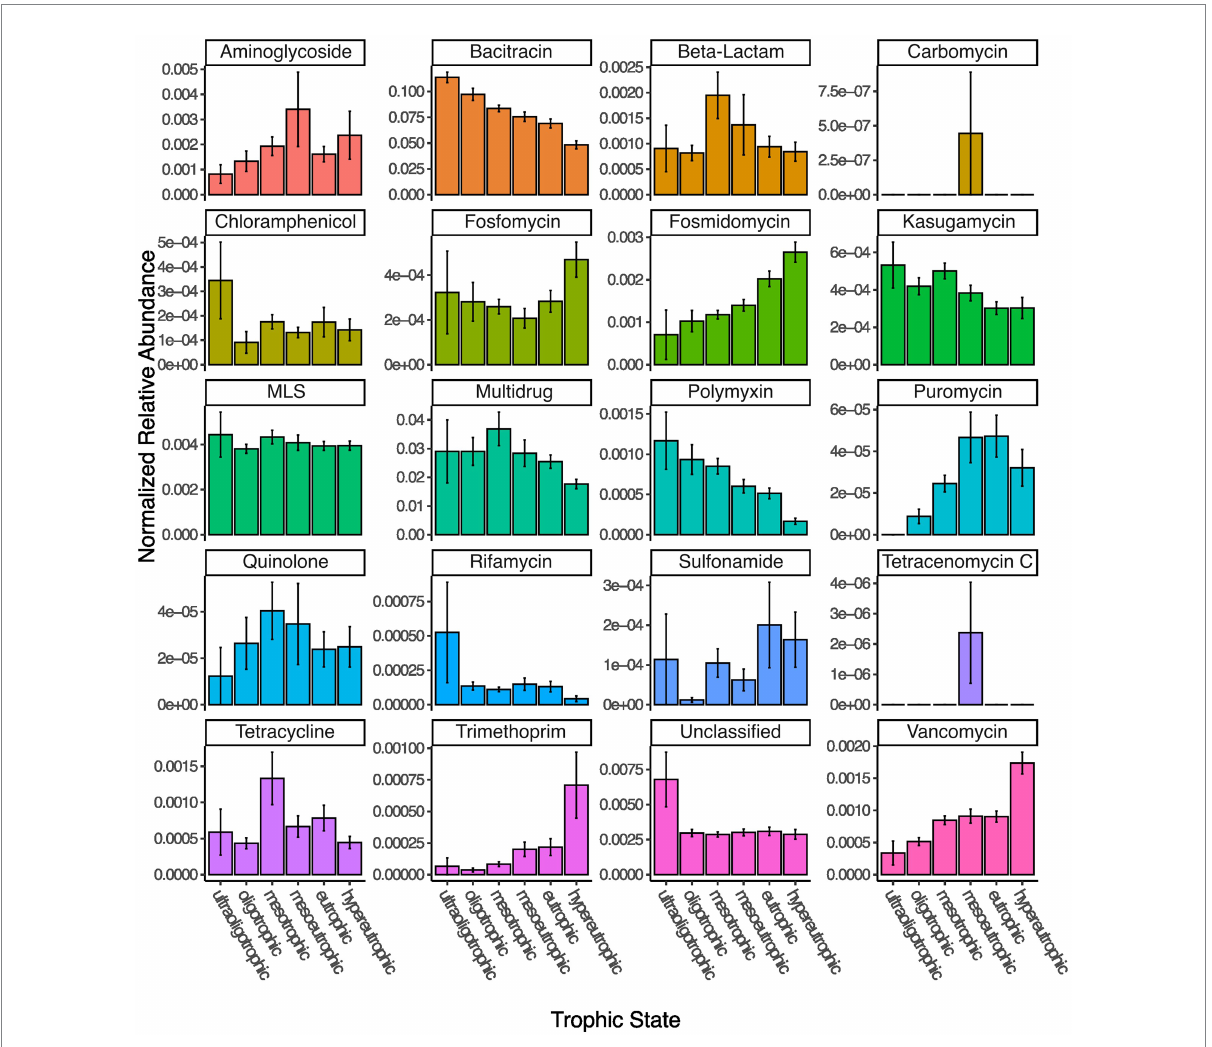
FIGURE 4 Normalized read abundances (by gene length and estimated number of genomes per sample) for 20 different classes of ARGs grouped by lake trophic